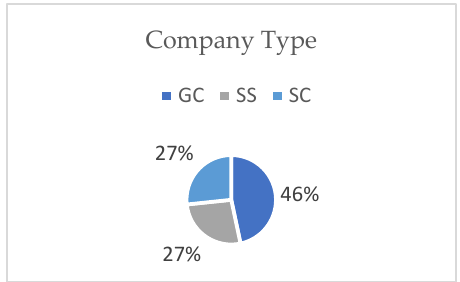
Figure 4. Company type (own study).